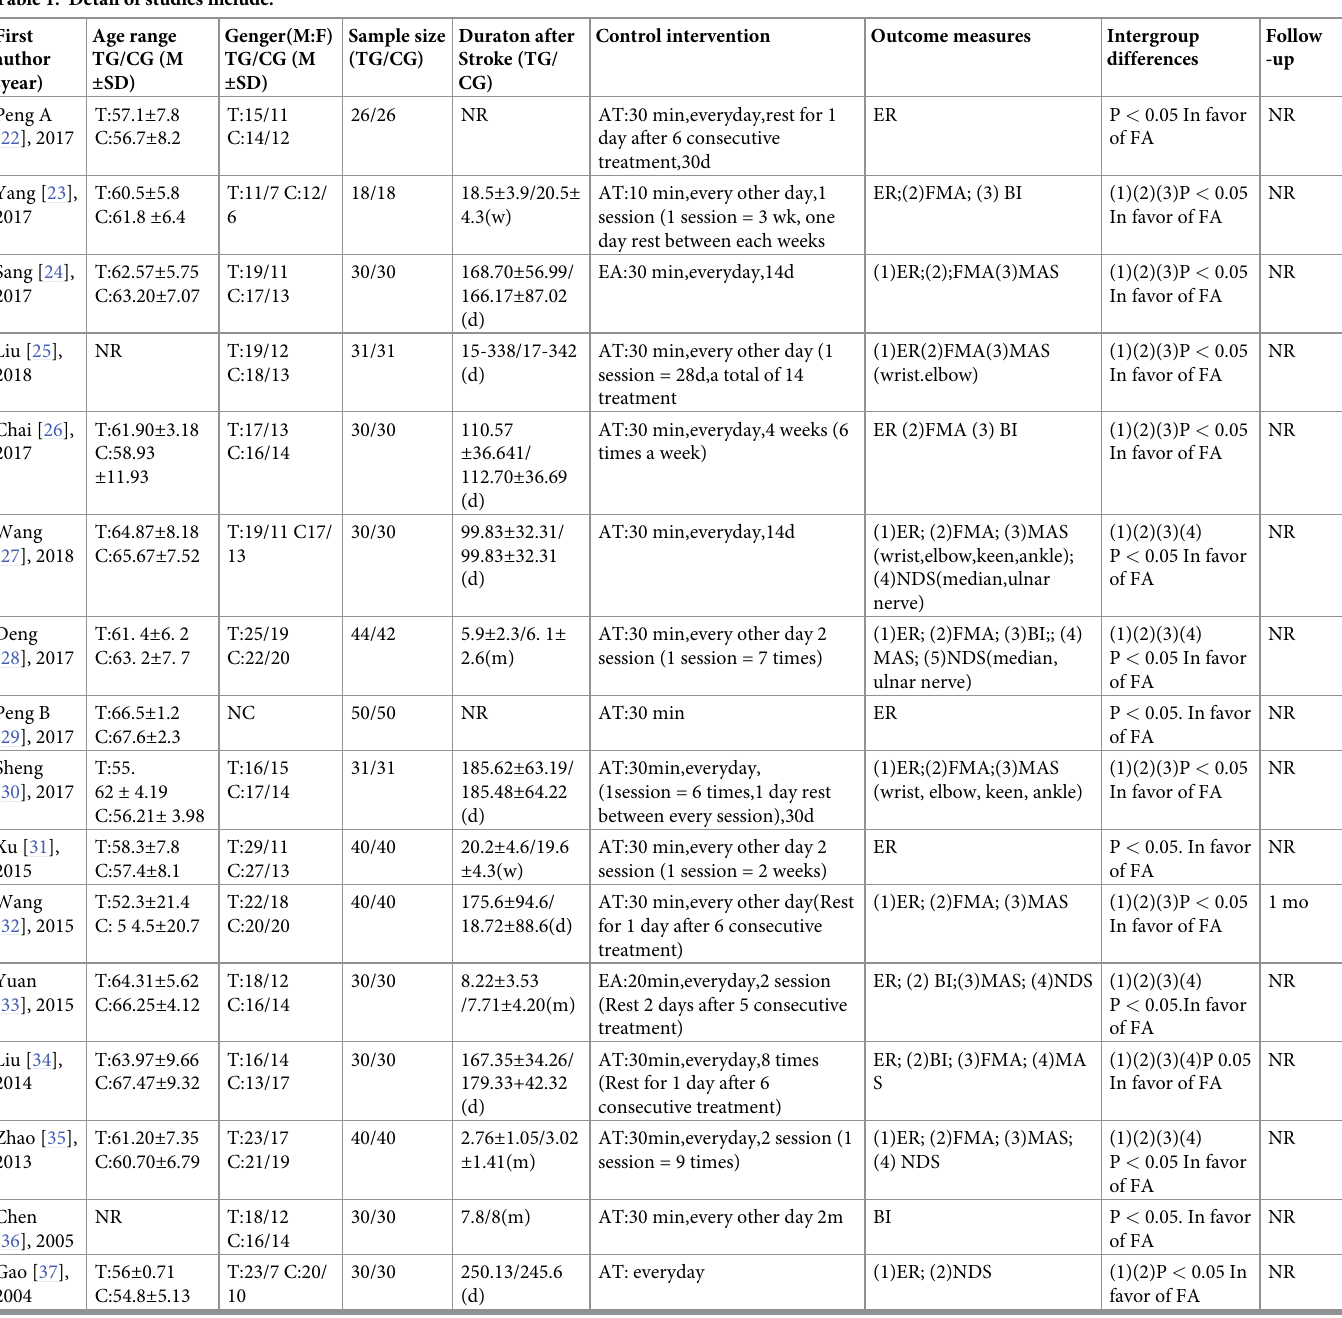
Table 1. Detail of studies